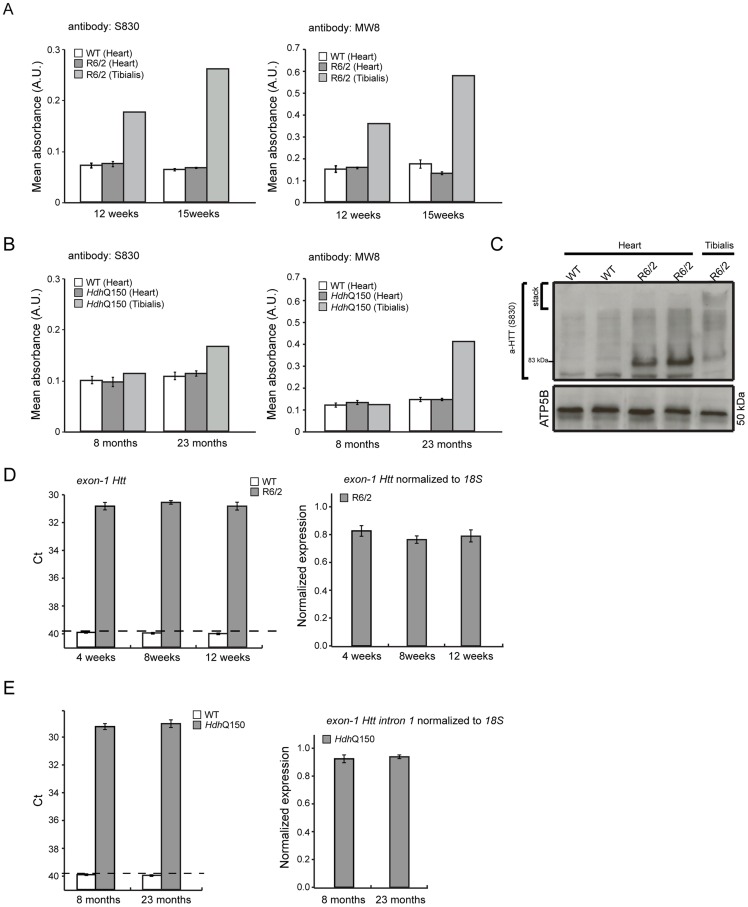
Mutant huntingtin aggregate species are not formed in the hearts of HD mouse models.(A, B) The seprion-ligand ELISA was used to identify and quantify aggregate loads in the heart lysates from R6/2 and HdhQ150 mice. Error bars are S.E.M. (n = 6). (C) Representative S830 immunoblot of protein lysates showing the difference in soluble and aggregated exon-1 HTT between heart and skeletal muscle (tibialis anterior) of R6/2 mice at 14 weeks of age. ATP5b was used as loading control (lower panel). (D, E) Taqman qPCR showed that HTT exon-1 transgene levels are stable during the course of disease progression in the murine heart of R6/2 and HdhQ150 mice. The dotted line indicates that the signal in WT animals occurs at the cut-off for gene expression. All Taqman qPCR values were normalized to the housekeeping gene 18S. Error bars are SEM (n = 6).